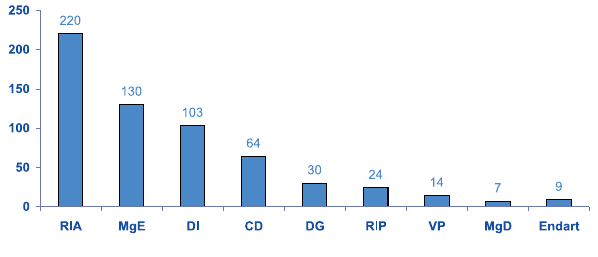
Fig. 2 - Artérias coronárias